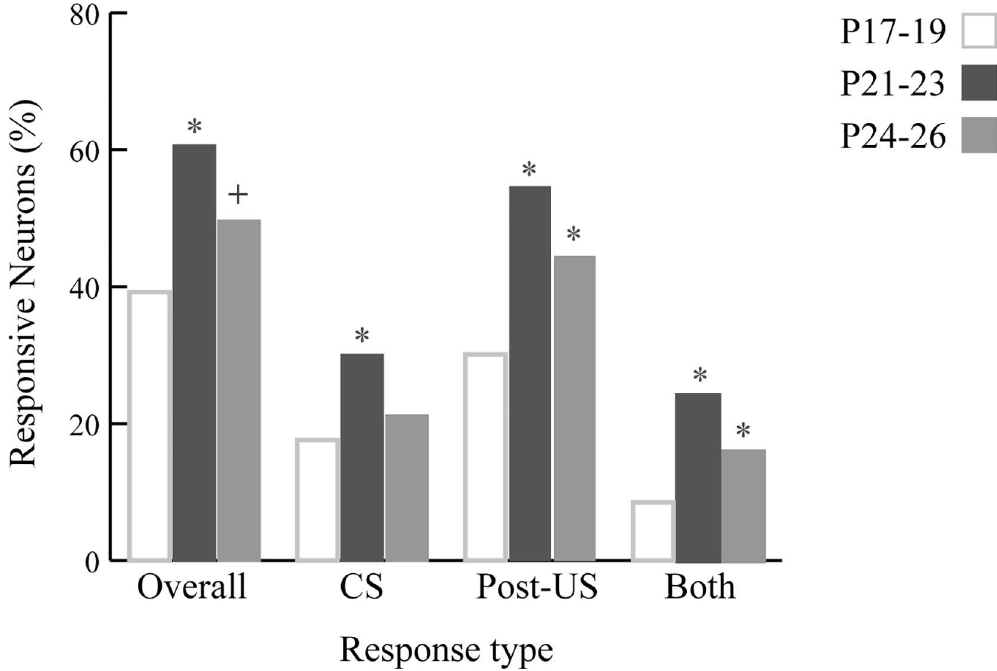
period, compared to the older age groups. Asterisks represent the statistical significanceof alpha < 0.05. Green cross indicates alpha =